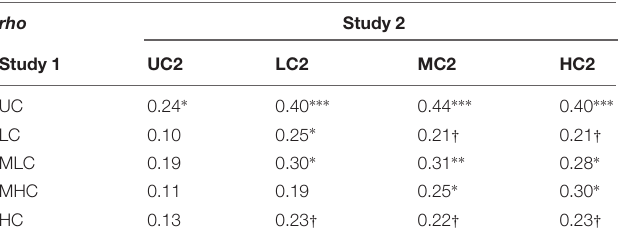
TABLE 5 | Spearman correlation coefficients for Study 1 and Study 2 ( n = 73). rho Study 2